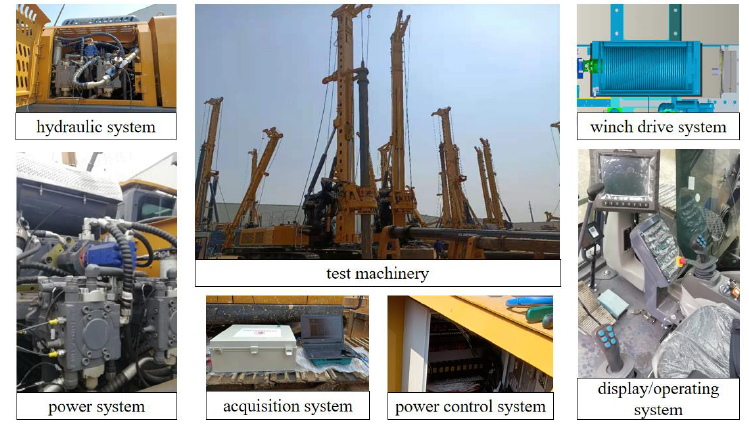
Figure 6. Test prototype and the photos of each part.